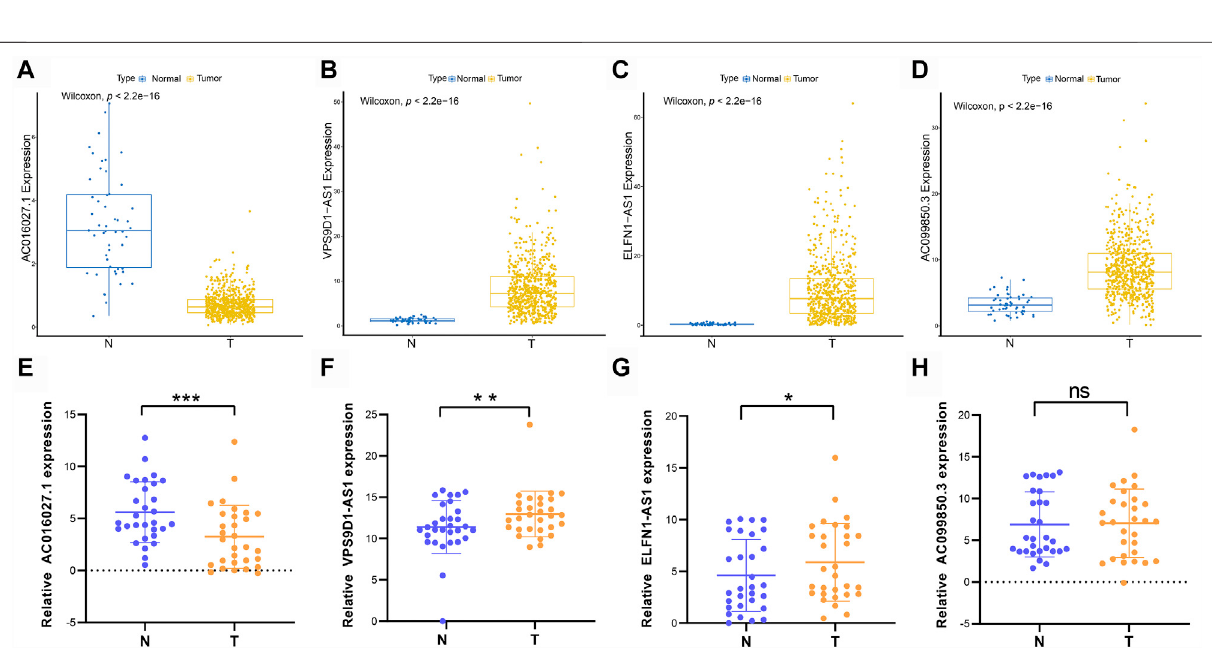
FIGURE 10 | Different expressions of prognostic DE-FLs in CRC tissues and TCGA. (A – D) The different expression levels of 4 DE-FLs in TCGA. (E – G) Q-PCR results demonstrated the down-regulated expression level of AC016027.1 and up-regulated level of VPS9D1-AS1 and ELFN1-AS1 in CRC tissues compared with paired normal tissues. (H) Q-PCR result of expression level of AC099850.3 in CRC tissues compared with paired normal tissues. *, p < 0.05. **, p < 0.01. ***, p <